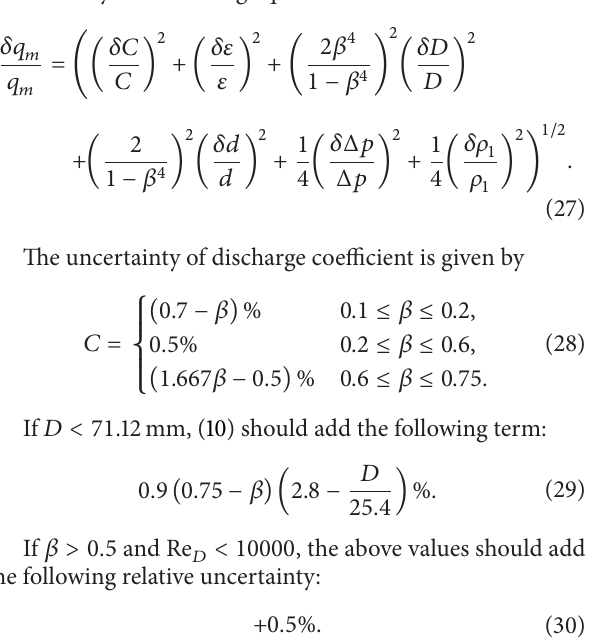
Table 3: The input and output values calculated by